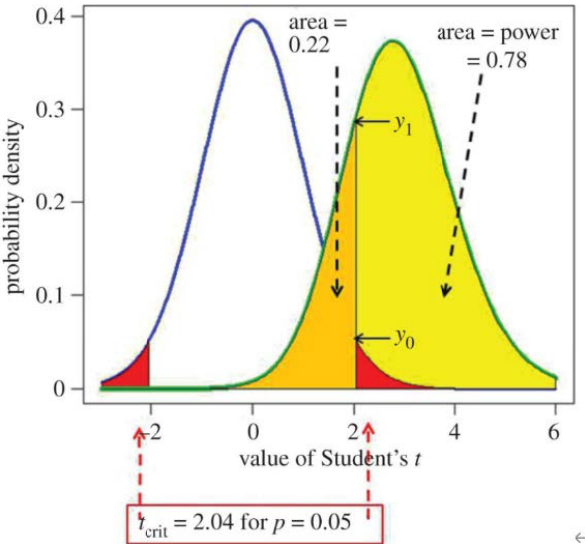
Fig. 4 The distribution of experimental test values in the confidence interval of the probability